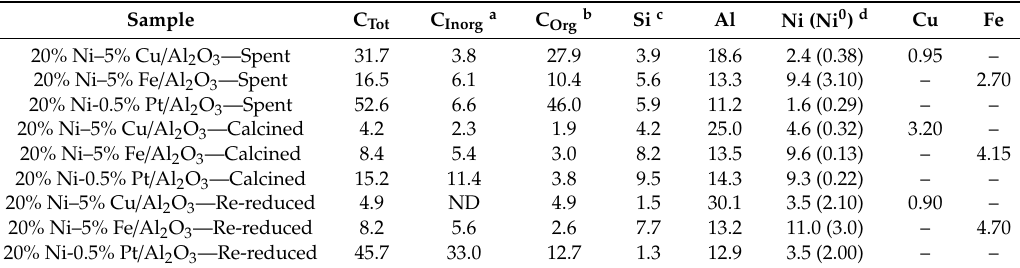
Table 2. Surface concentration (at.%) of elements detected via